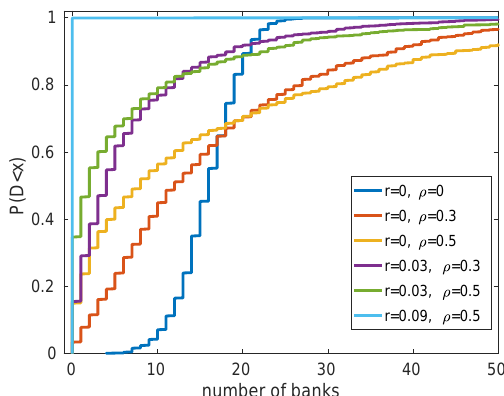
Figure 5. Empirical CDF of D , the number of banks in default, with N = 100 banks, 1000 simulations, µ i = σ i = 0.1 for i = 1, . . . , N .